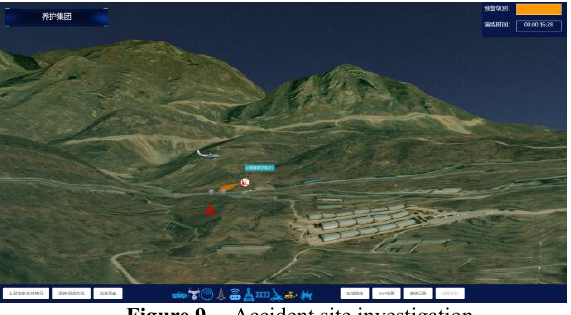
Figure 9. Accident site investigation